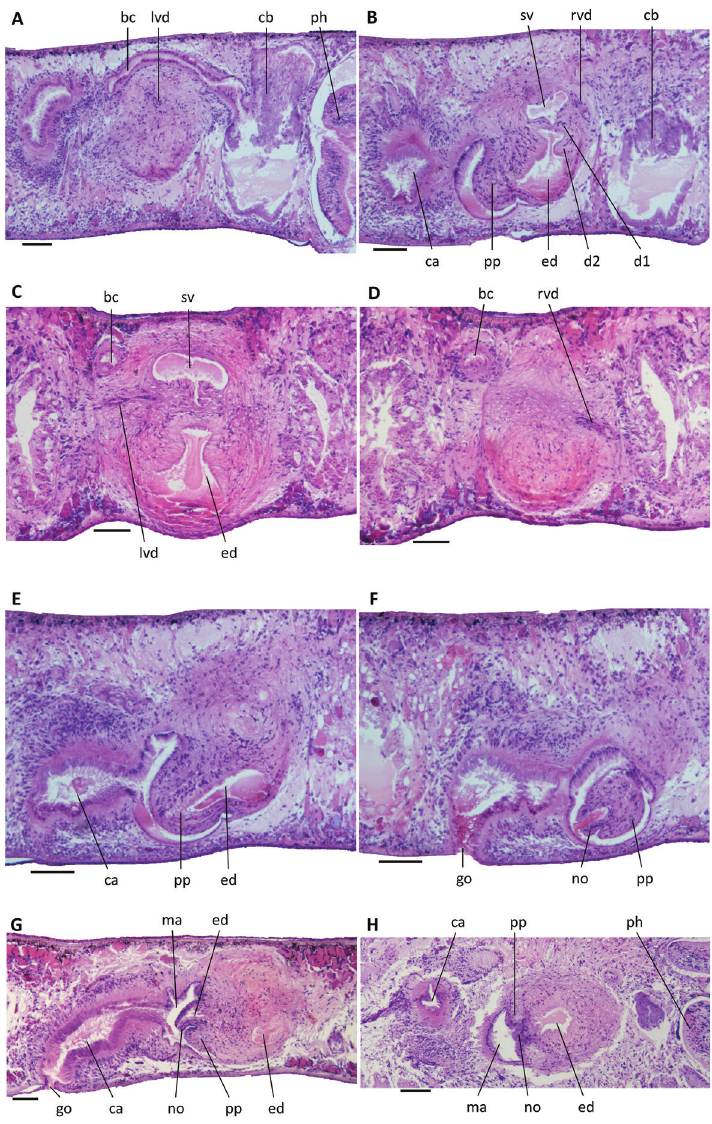
Figure 6. Dugesia circumcisa A sagittal section of holotype YWSZ2, showing bursal canal and copula- tory bursa B sagittal section of holotype YWSZ2, showing opening of the right vas deferens into seminal vesicle, and two diaphragms C transverse section of paratype YWSZ11, showing left vas deferens, seminal vesicle, and ejaculatory duct D transverse section of paratype YWSZ11, showing right vas deferens E sagit- tal section of holotype YWSZ2, showing ejaculatory duct F sagittal section of holotype YWSZ2, showing small nozzle at tip of penis papilla G sagittal section of paratype YWSZ9, showing small nozzle at tip of pe- nis papilla and the duct connecting male and common atrium H horizontal section of paratype YWSZ12, showing small nozzle at tip of penis papilla. Abbreviations: bc: bursal canal; ca: common atrium; cb: copulatory bursa; d: diaphragm; ed: ejaculatory duct; go: gonopore; lvd: left vas deferens; ma: male atrium; no: nozzle; ph: pharynx; pp: penis papilla; rvd: right vas deferens; sv: seminal vesicle. Scale bars: 100